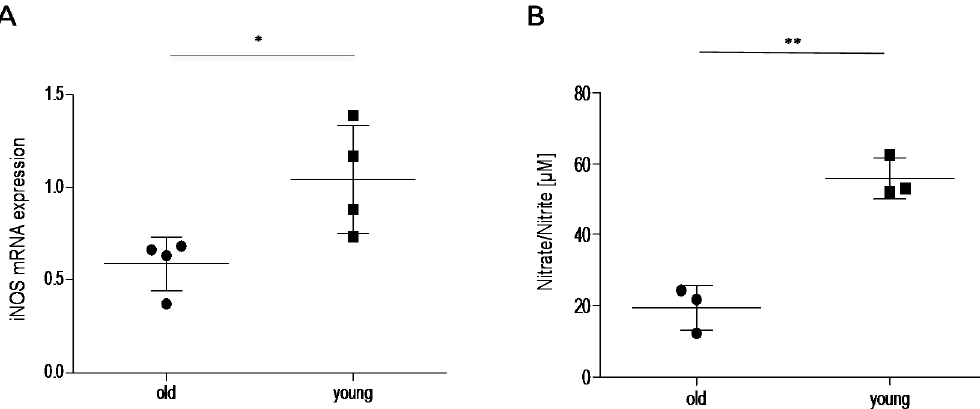
Figure 6. Effect of age on expression and activity of iNOS in the spinal cord of mice 45 min after formalin injection. ( A ) iNOS mRNA expression in the spinal cord of young and old mice 45 min after formalin injection into the hind paw, analyzed by qRT-PCR ( n = 4/group); ( B ) iNOS activity as assessed by Griess assay, ( n = 3), * p < 0.05, ** p < 0.01, statistically significant difference between the groups.